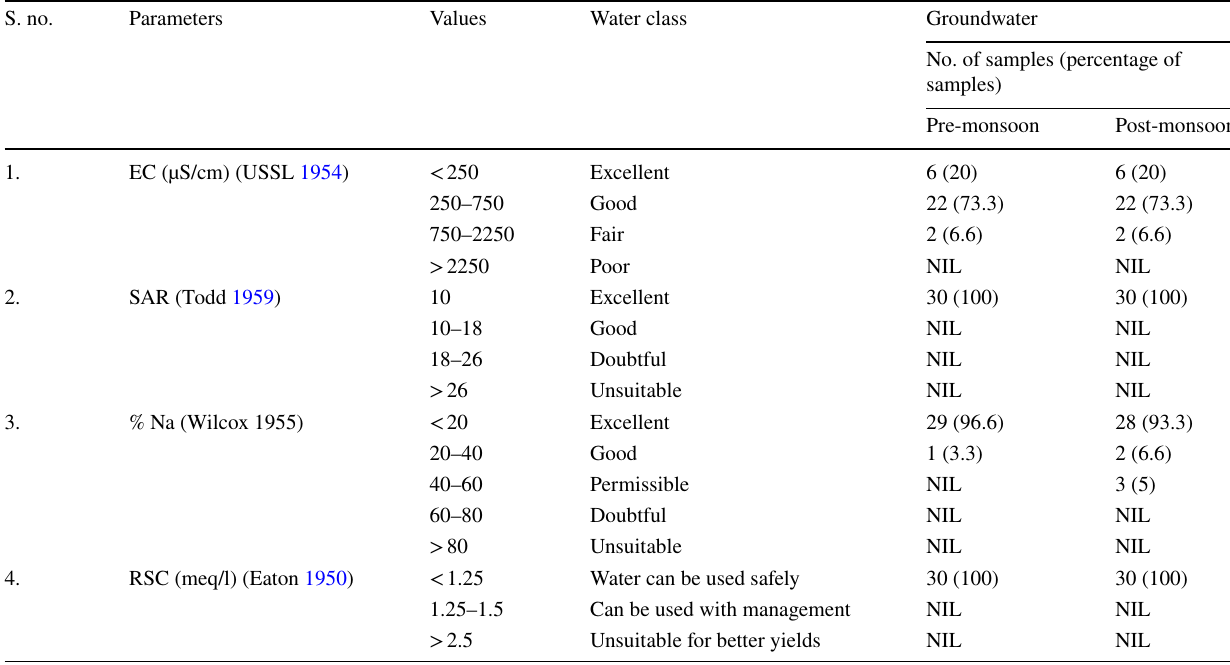
Table 9 Different criteria of water suitability for irrigation purposes S.